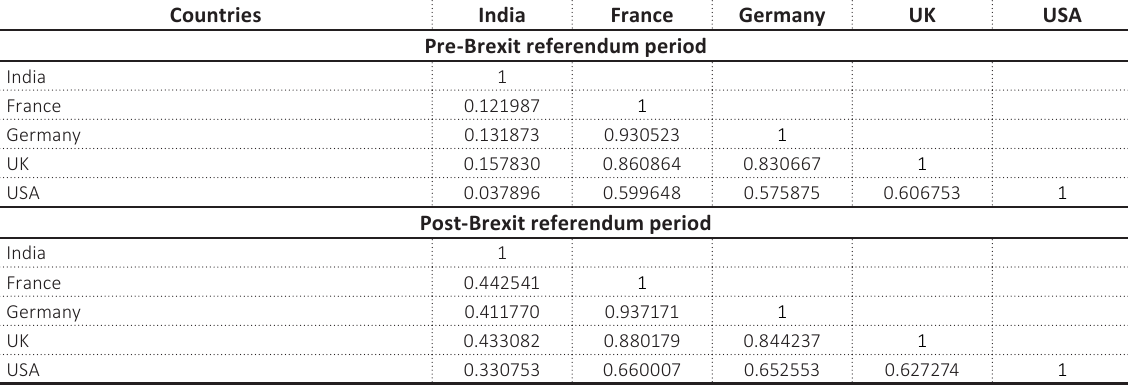
Table 3. Pre-Brexit referendum period, VAR model Vector Autoregression